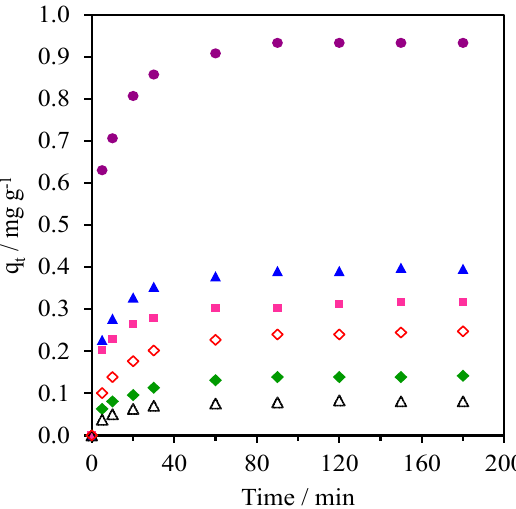
Figure 9. Kinetic curves of CFA adsorption onto ( Δ ) WMS, ( ◊ ) WMS-0.10, ( ⧫ ) NR/WMS, ( ● ) NR/WMS-0.05, ( ▲ ) WMS-0.10 and ( ■ ) NR/WMS-0.15. Table 3. Kinetic parameters of CFA adsorption onto the